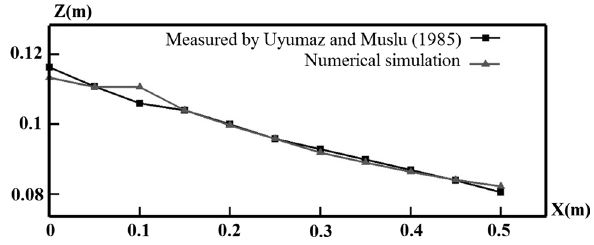
Fig. 5 Comparison of the experimental and numerical results of pass- ing flow over side